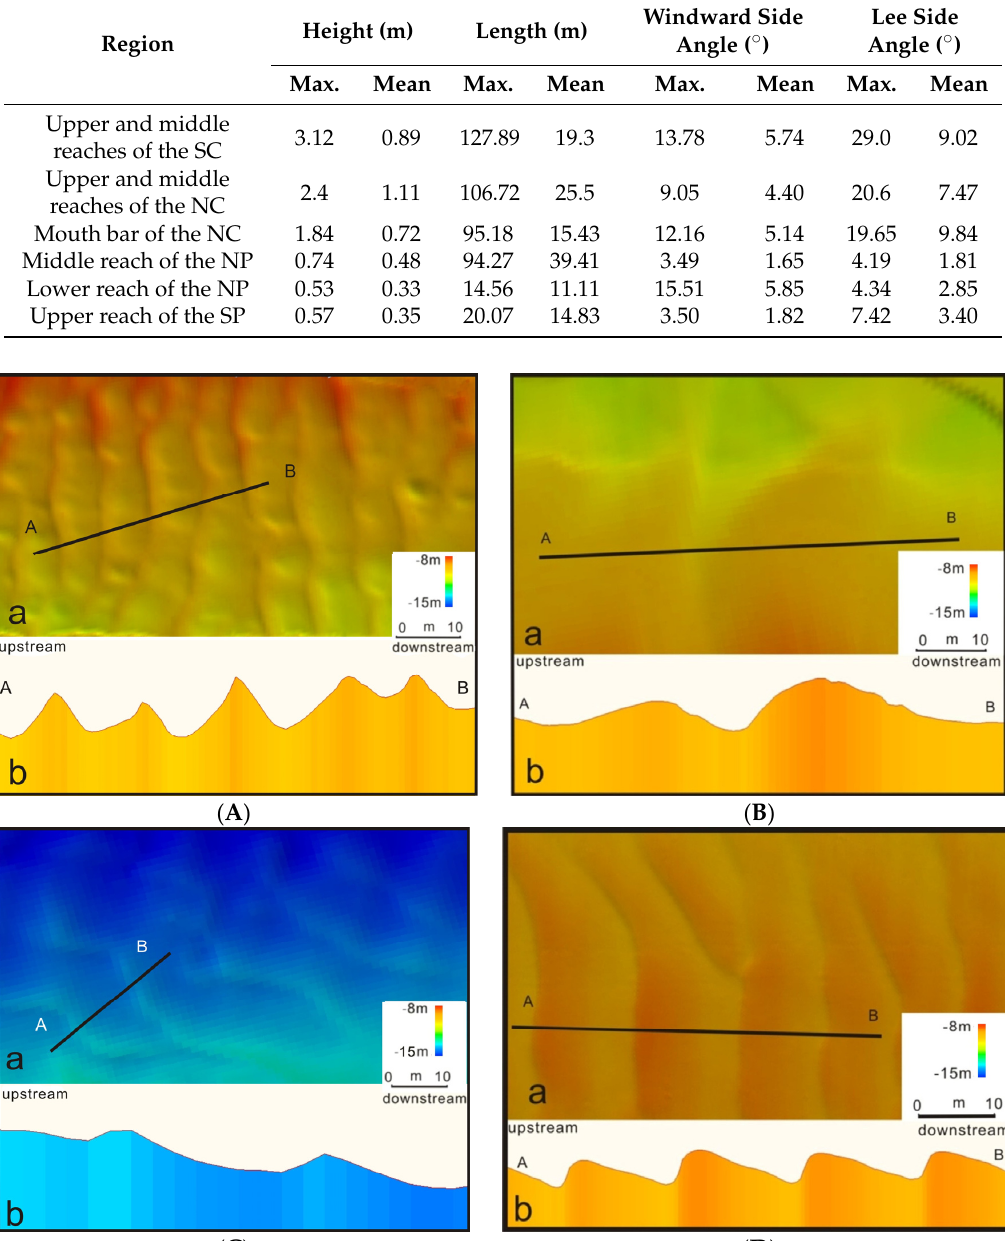
Table 1. Characteristics of dunes in the middle and upper reaches, and the turbidity maximum zone of the Yangtze River estuary.